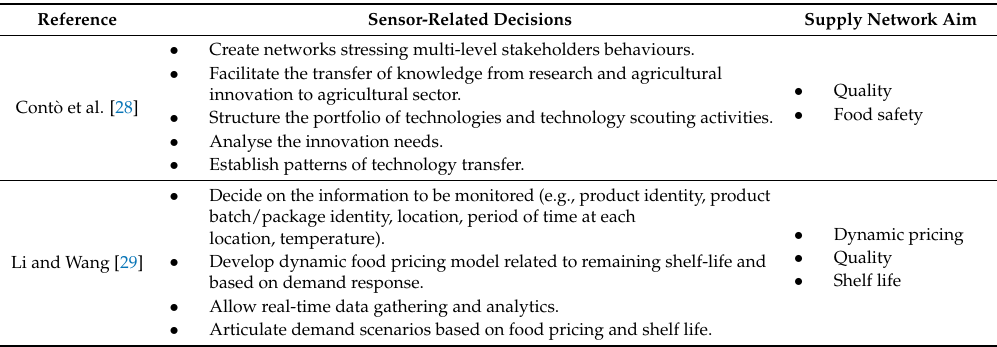
Table 1. Sensor-related decisions in food supply